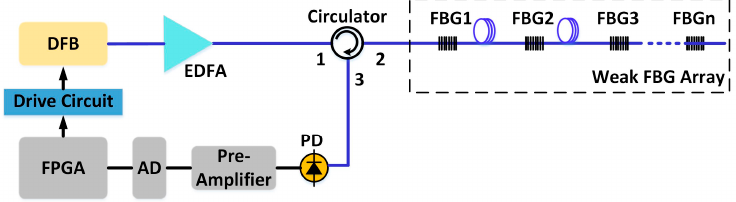
Figure 1. Schematic of a high-speed weak fiber Bragg grating (FBG) interrogation system based on a distributed feedback (DFB) laser.